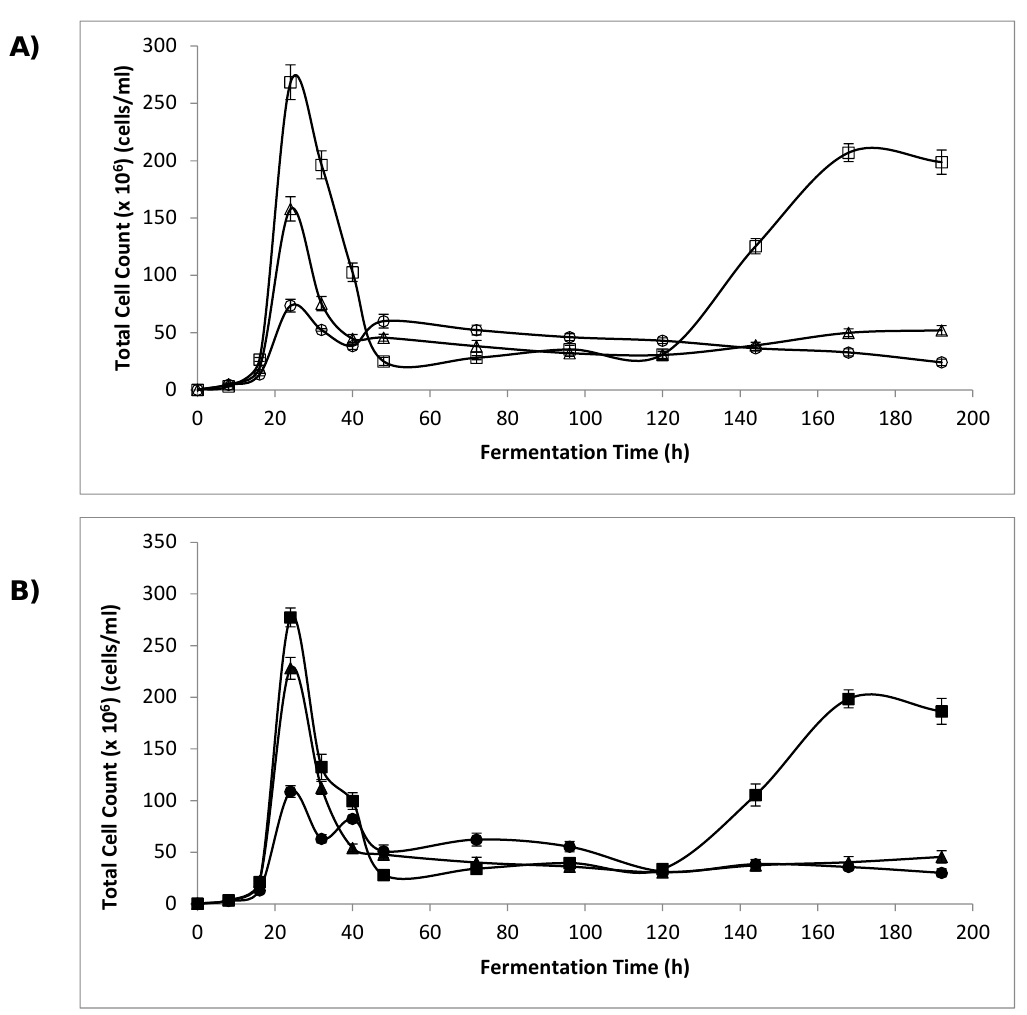
Figure 3. ( A ) Total cell count (cells/mL) of non-NaCl-stressed cells during various fermentation times (h) with three different media containing 200, 300, or 400 g/L glucose after cell treatment with sonication ( n = 3 replications for each time and error bars represent standard deviation of the average value of all replications with each range of fermentation time); ( B ) Total cell count (cells/mL) of NaCl-stressed cells during various fermentation times (h) with three different media containing 200, 300, or 400 g/L glucose after cell treatment with sonication ( n = 3 replications for each time and error bars represent standard deviation of the average value of all replications with each range of fermentation time) ( (200 g/L glucose, 0% NaCl), ( ∆ ): (300 g/L glucose, 0% NaCl), ( (cid:3) ): (400 g/L glucose, 0% NaCl), ( ): (200 g/L glucose, 6% NaCl), ( (cid:78) ): (300 g/L glucose, 6% NaCl), ( (cid:4) ): (400 g/L glucose, 6%